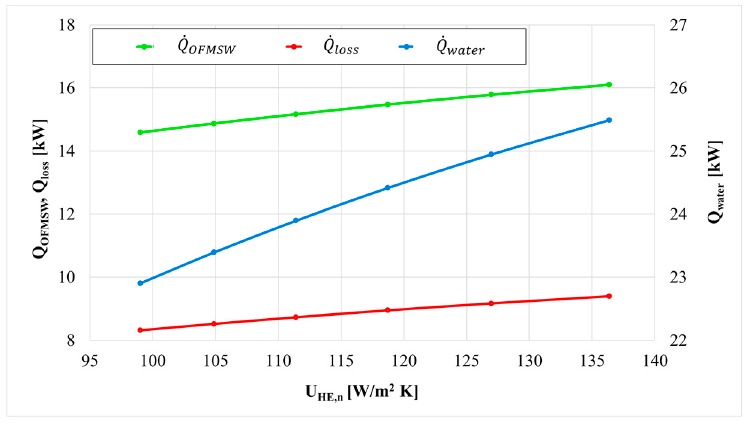
. . . . m & = 0.174 kg/s, m & = 0.557 Q & , Q & , Q & vs U Q OFMSW , Q loss , Q water vs. U HE,n for m OFMSW = 0.174 kg / s, HE,n for OFMSW water OFMSW loss water